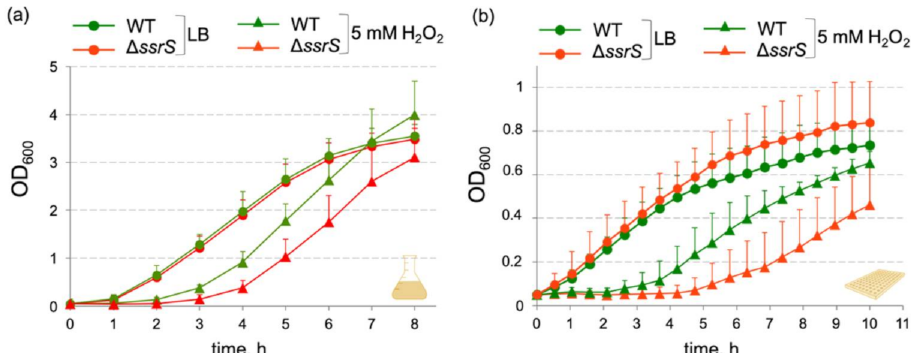
Figure 1. Lack of 6S RNA leads to an extended delay in outgrowth of E. coli cell cultures in the presence of 5 mM H 2 O 2 . Growth curves of E. coli MG1655 WT (green symbols) and ∆ ssrS bacteria (red symbols) in LB medium in the absence or presence of 5 mM H 2 O 2 . Cells were either grown in liquid culture flasks ( a ) or in a 96-well microtiter plate format ( b ) with manual monitoring of optical density at 600 nm (OD 600 ) in three and six biological replicates,